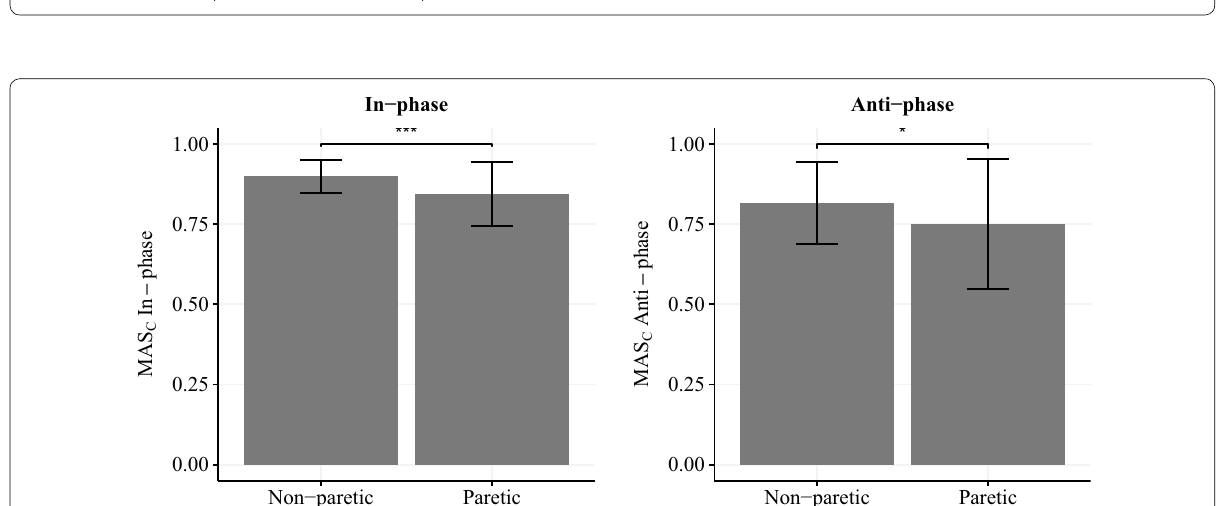
Fig. 8 Lateral activation similarity (LAS) indicates that the contralateral similarity in EMG measured under coupling is from the same as that measured under uncoupled tasks. The whiskers represent ± SD